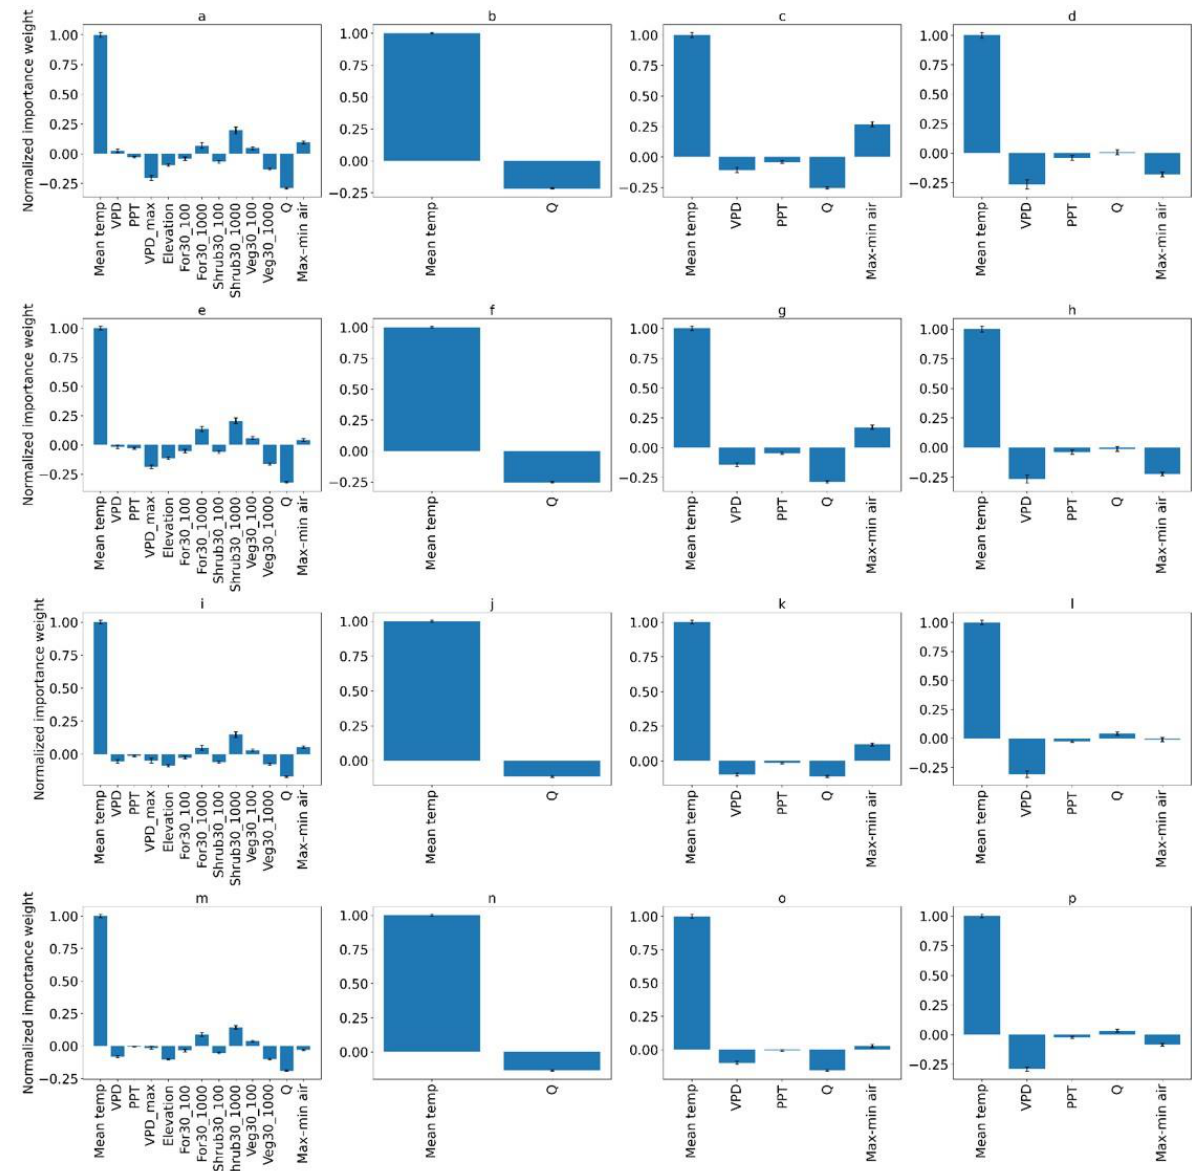
Figure 10. Scaled importance of each environmental variable. Values can range from − 1 to 1, with positive values indicating that an increase in the parameter (e.g., increased air temperature) results in an increase in stream temperature and vice versa. The closer the value is to zero, the lower the importance. Scenarios shown are ( a ) 7DADM, ( b ) _Q+A, ( c ) 7DADM_Oct– May, ( d ) 7DADM_Jun–Sept, ( e ) 7DA, ( f ) 7DA_Q+A, ( g ) 7DA_Oct–May, ( h ) 7DA_Jun–Sept, ( i ) max, ( j ) max_Q+A, ( k ) max_Oct–May, ( l ) max_Jun–Sept, ( m ) mean, ( n ) mean_Q+A, ( o ) mean_Oct–May, and ( p ) mean_Jun–Sept.